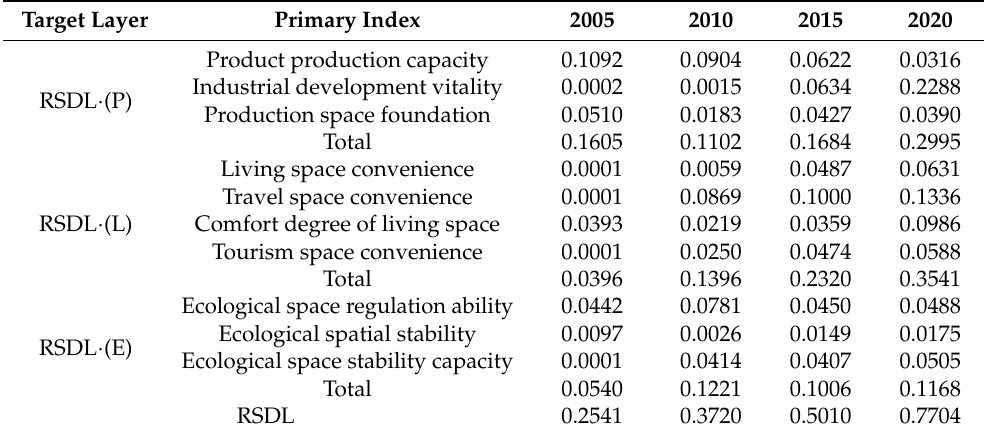
Figure 3. The spatial distribution of production – living – ecological space in East Tumen Village and West Tumen Village from 2005 to 2020. Table 3. Evaluation results of rural spatial development level (RSDL) index in East Tumen Village and West Tumen